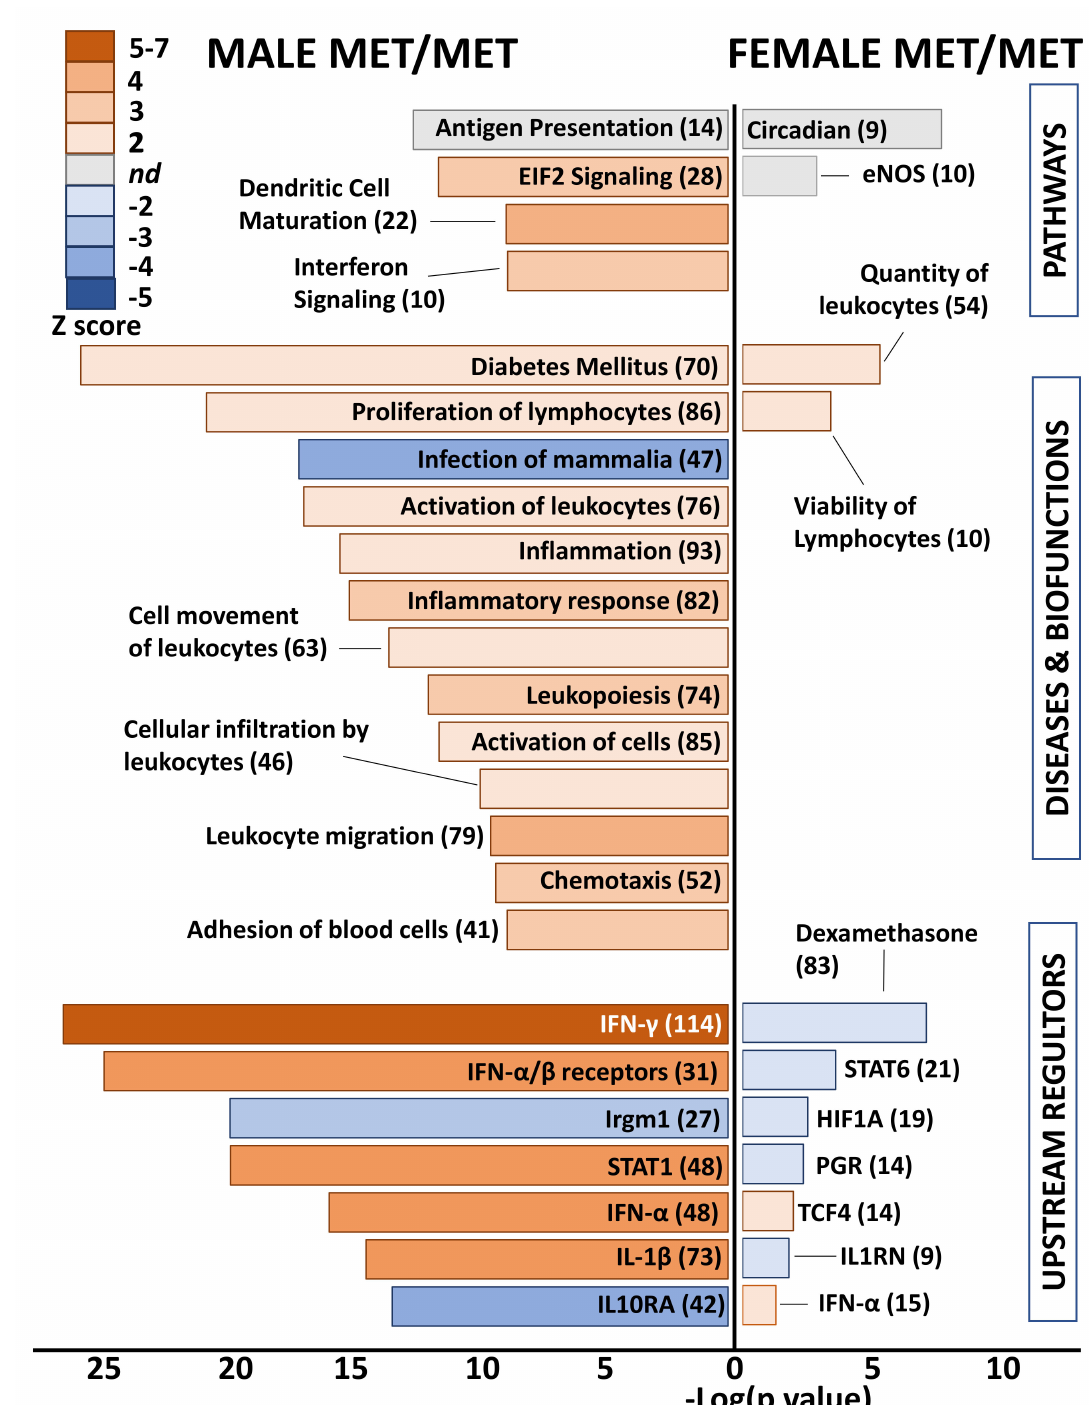
Figure 3. Met/Met mice exhibit a male-specific inflammatory profile. Bar chart shows enriched pathways ( top bars), diseases and biofunctions ( middle bars), and predicted upstream regulators ( bottom ) for whole hearts of male ( left side) and female ( right side) Met/Met mice compared to those of normal Val/Val controls. Bar size reflects significance (shown on x axis), and color represents Z score (significance of prediction of directionality), as indicated in the legend. Numbers in parentheses indicate numbers of genes in the listed category that were altered in hearts of either male or female Met/Met mice compared to respective